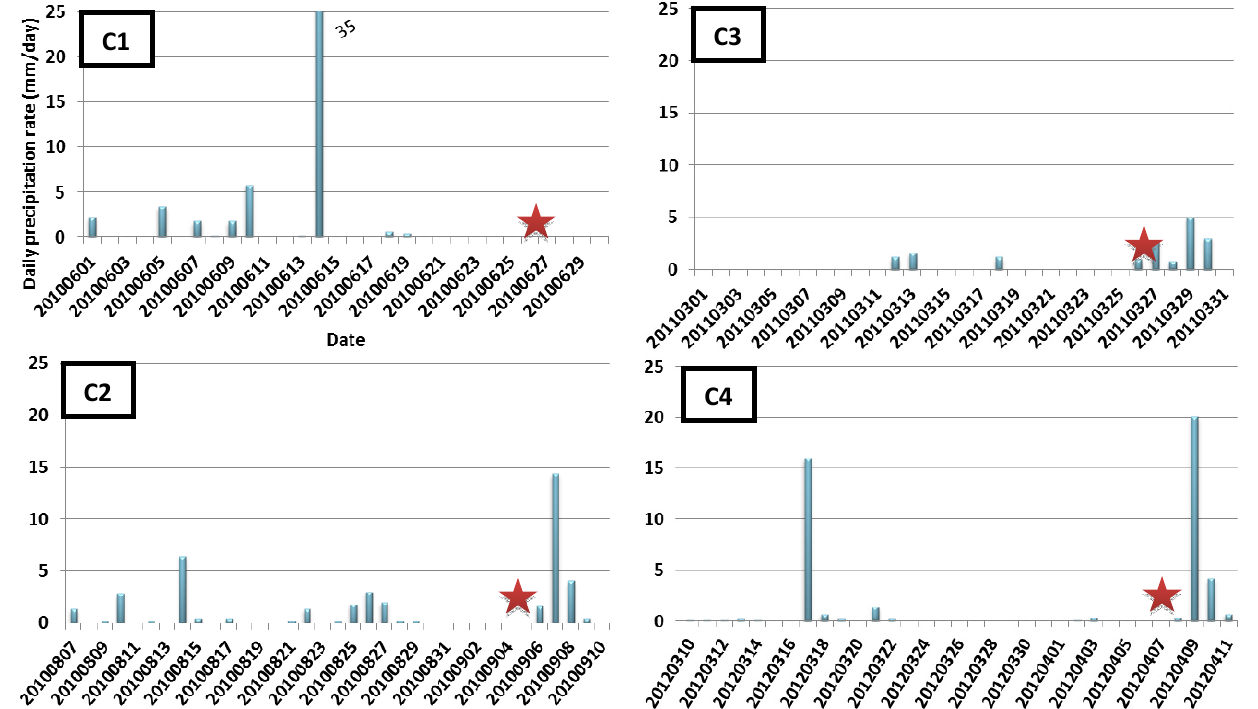
Figure 2. Daily precipitation rate of the four sampling campaigns (experimental datasets); : correspond to the sampling